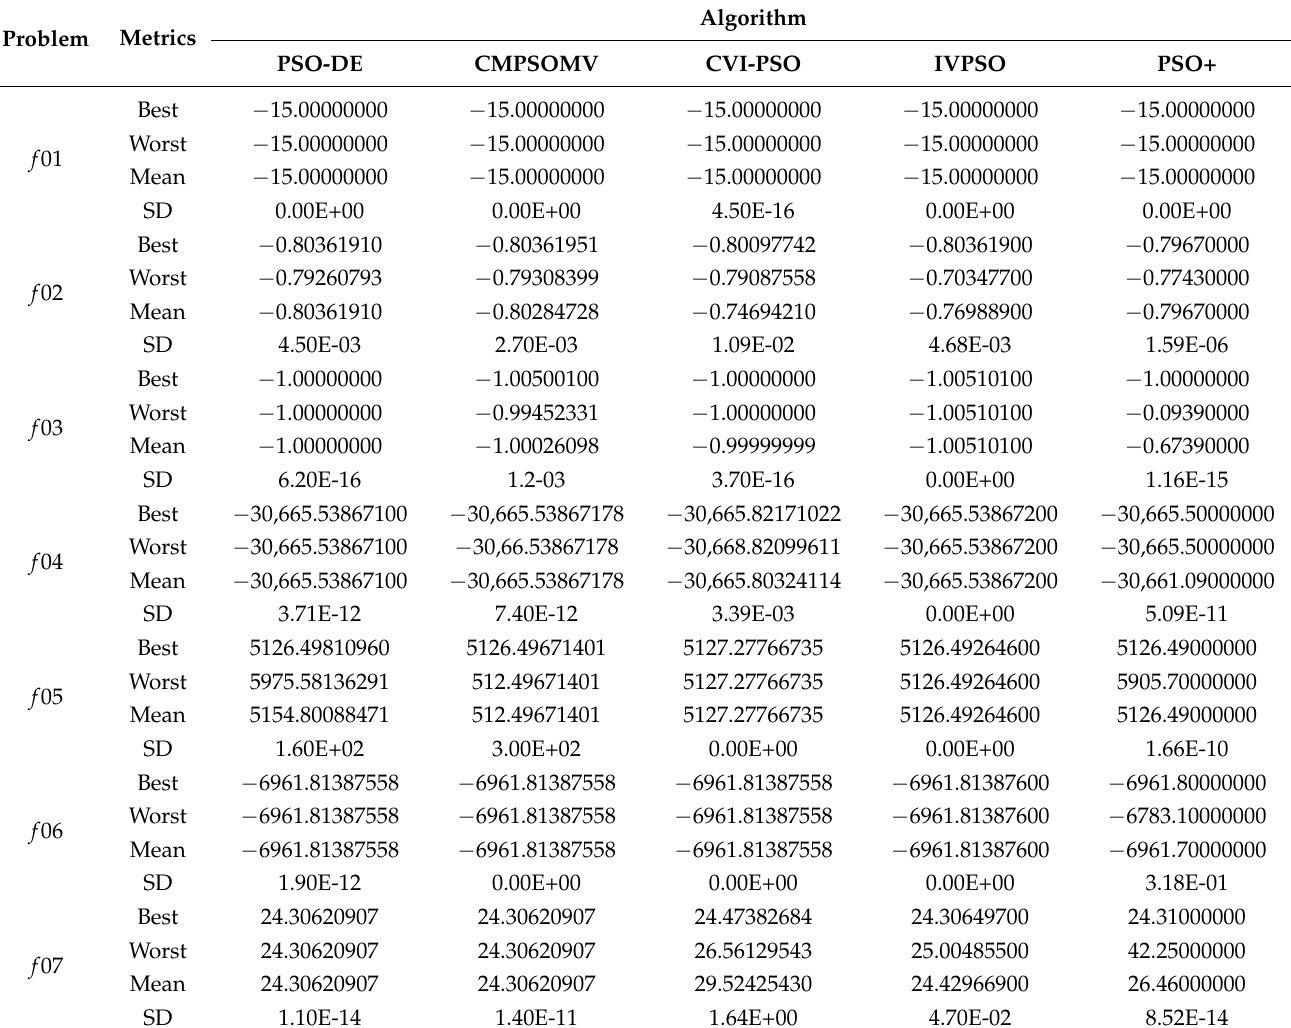
Table 3. The results of PSO-DE compared with PSO variant algorithms in benchmark